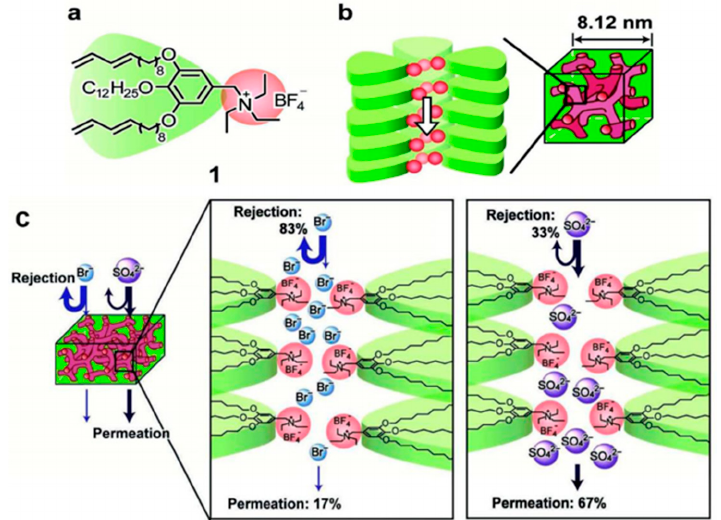
Figure 5. ( a ) Chemical structure of the liquid-crystal molecule 1; ( b ) Self-assembled bicontinous cubic (Cub bi ) structure forming ionic nanochannels of 1; ( c ) Schematic representation of selective rejection of anions through the Cub bi membranes. Figures reprinted with permission from Ref. [89]. Copyright Wiley-VCH,